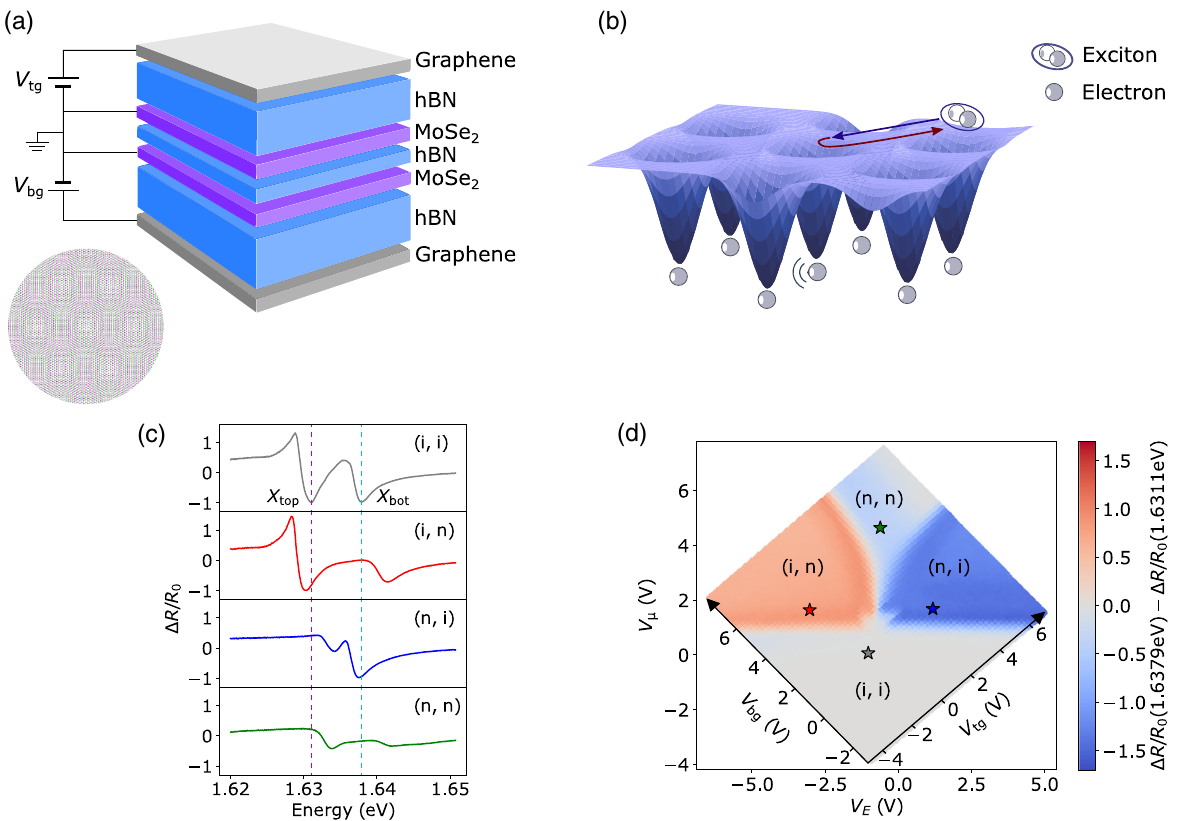
FIG. 1. Moir´e lattice in MoSe 2 = hBN = MoSe 2 and basic characterization. (a) Schematic picture of the device structure. The left bottom picture shows a moir´e lattice. (b) Schematic picture of the potential for excitons created by electrons trapped in a moir´e lattice. (c) Differential reflectance spectrum for each charge configuration. “ i ” and “ n ” indicate neutral and electron doped charge configurations and are shown in the order of (top, bottom). (d) Color map of layer contrasted differential reflectance signal [ Δ R=R 0 ð 1 . 6379 eV Þ − Δ R=R 0 ð 1 . 6311 eV Þ